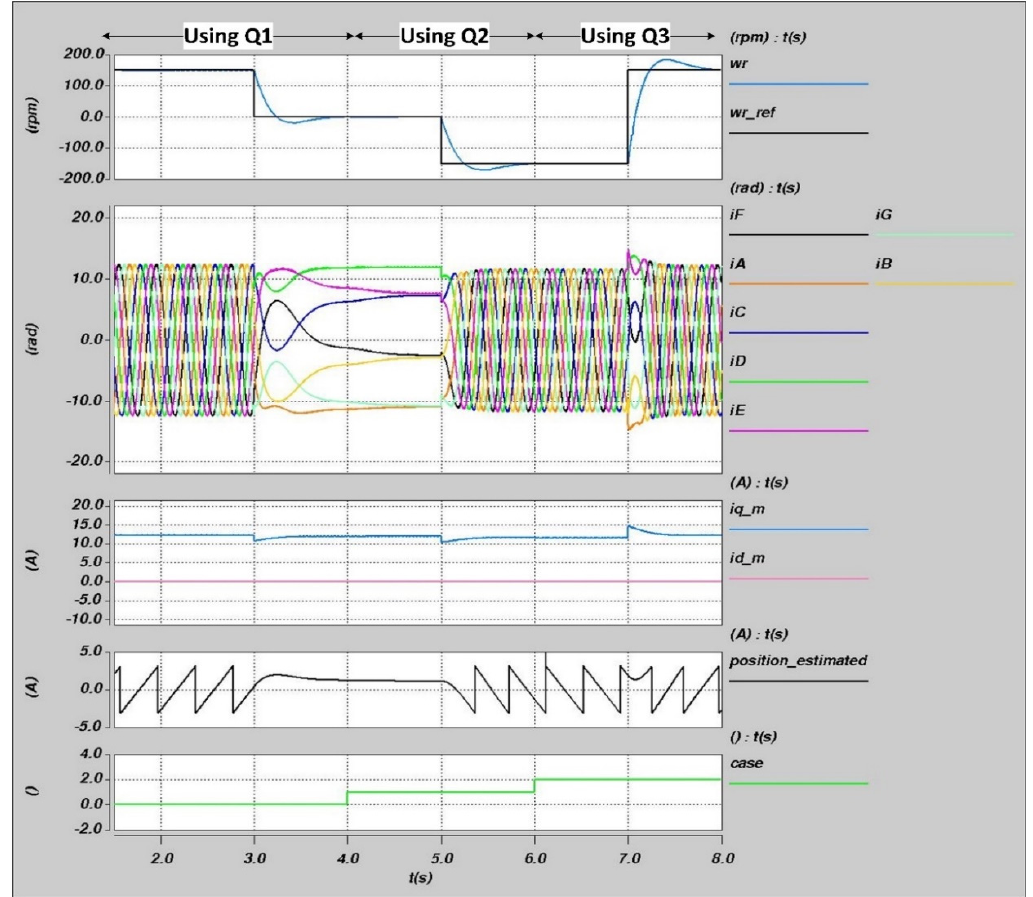
Figure 15. Sensorless speed control results.